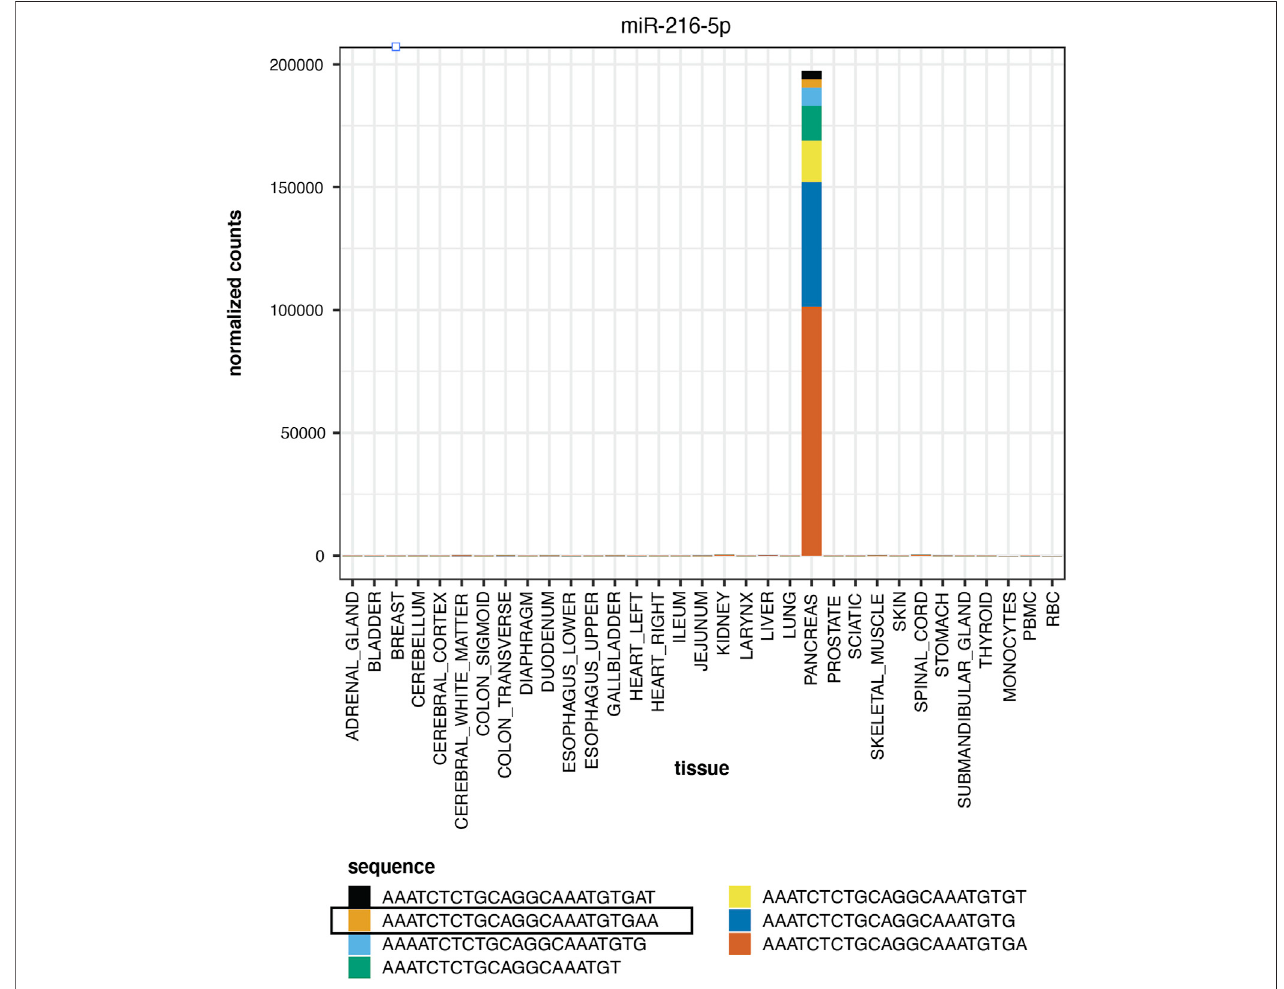
FIGURE5| TissueElevation.miR-216-5piselevatedinpancreas.TheexpressionofthematuresequenceishighlightedinPanel.Thestackedbarplotdisplaysthe relative proportion of other miR-216-5p isomiRs, all of which are elevated in pancreas.